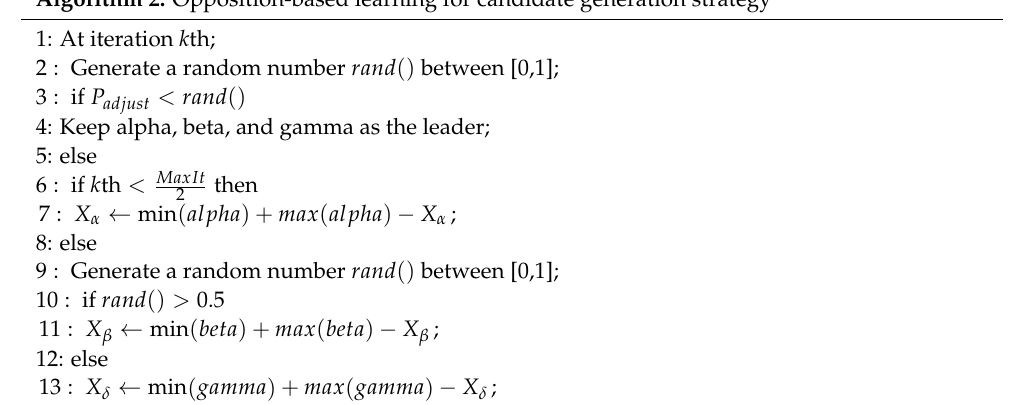
Algorithm 2. Opposition-based learning for candidate generation